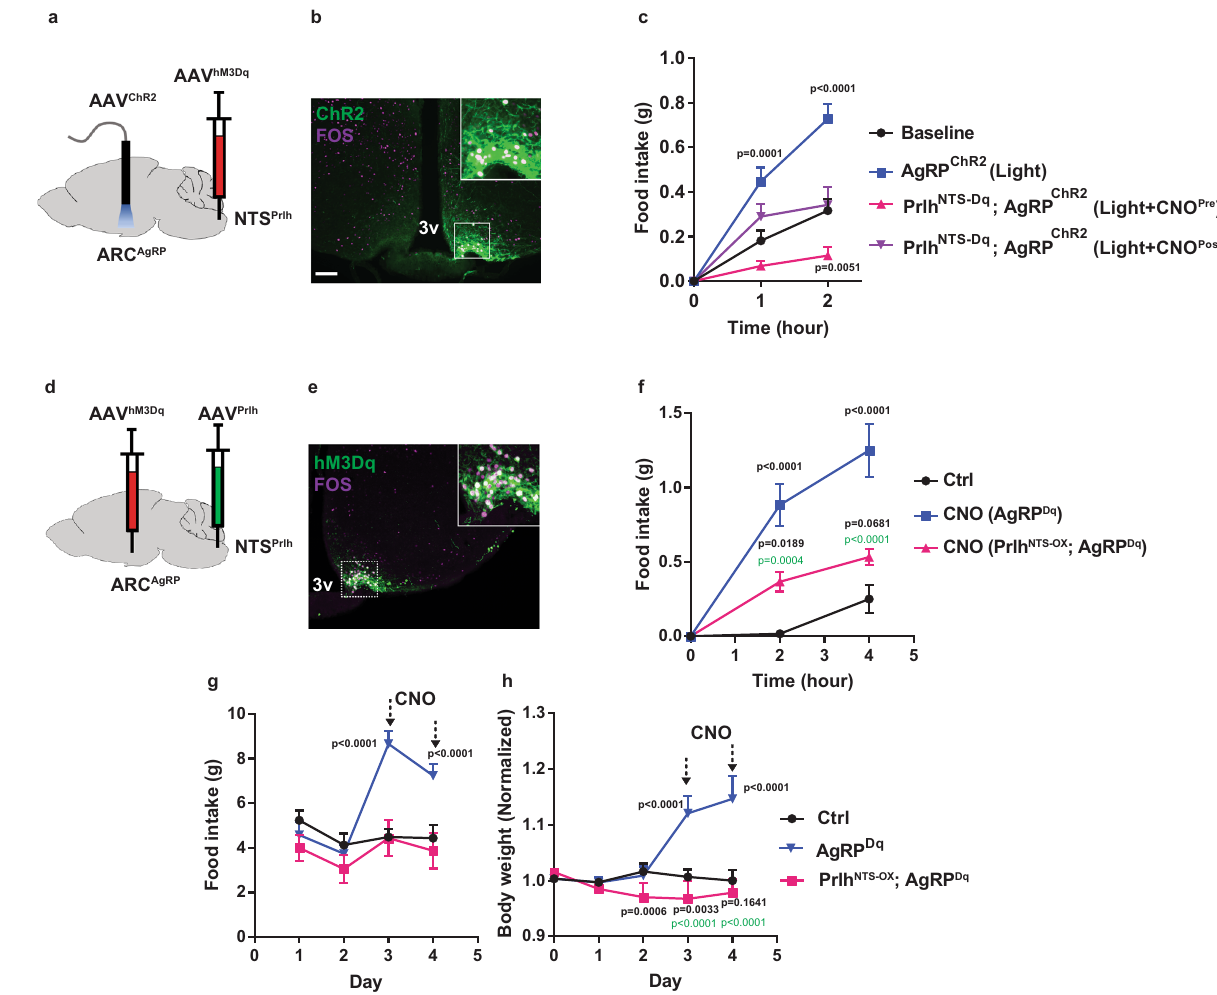
Fig. 5 Prlh NTS action abrogates AgRP neuron-promoted food intake and weight gain. A Schematic showing the stereotaxic injection of AAV Flex-hM3Dq into the NTS and AAV Flex-ChR2 plus optical fi ber into the ARC of Prlh cre ;Agrp cre mice. B Representative image of GFP-IR (ChR2, green) and FOS-IR (magenta) in the ARC of mice treated as in ( A ), following photostimulation for 1 h. C Cumulative food intake for the fi rst 1 or 2 h of treatment for mice as in ( A ) that were unstimulated (black), photostimulated (blue), CNO-treated immediately prior to photostimulation (CNO Pre , red), and CNO-treated following the fi rst hour of photostimulation (CNO Post , purple); n = 9 animals in baseline group; n = 10 in light group; n = 7 in Light + CNO Pre group, and n = 8 in Light + CNO Post group. D Schematic showing the stereotaxic injection of AAV Flex-hM3Dq into the ARC of Prlh cre ;Agrp cre mice (AgRP Dq mice); some mice also received AAV Flex-Prlh into the NTS (NTS Prlh ;AgRP Dq mice). E Representative image showing mCherry-IR (hM3Dq, green (pseudocolored)) and FOS-IR (magenta) in the ARC of NTS Prlh ;AgRP Dq mice following CNO treatment for 2 h. F Food intake during the fi rst 4 h of the dark cycle for CNO (IP, 1